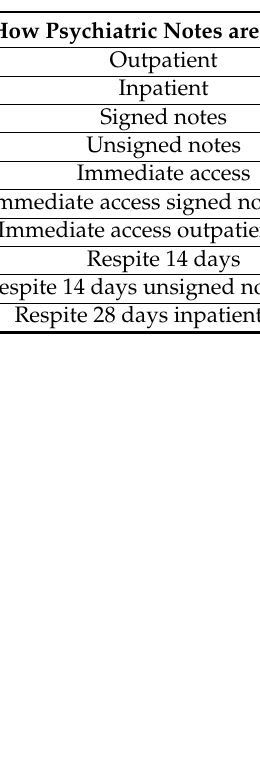
Table 2. How psychiatric notes are shared in each region/private care provider. Note: (Light and dark) blue colour = YES, and N/A = not applicable. (Region number) 1 Blekinge, 2 Dalarna, 3 Gotland, 4 Gävleborg, 5 Jönköping, 6 Kalmar, 7 Kronoberg, 8 Norrbotten, 9 Skåne, 10 Stockholm, 11 Uppsala, 12 Värmland, 13 Västernorrland, 14 Västmanland, 15 Västra Götaland, 16 Örebro, 17 Östergötland. (Private care provider number) 18 Capio, 19